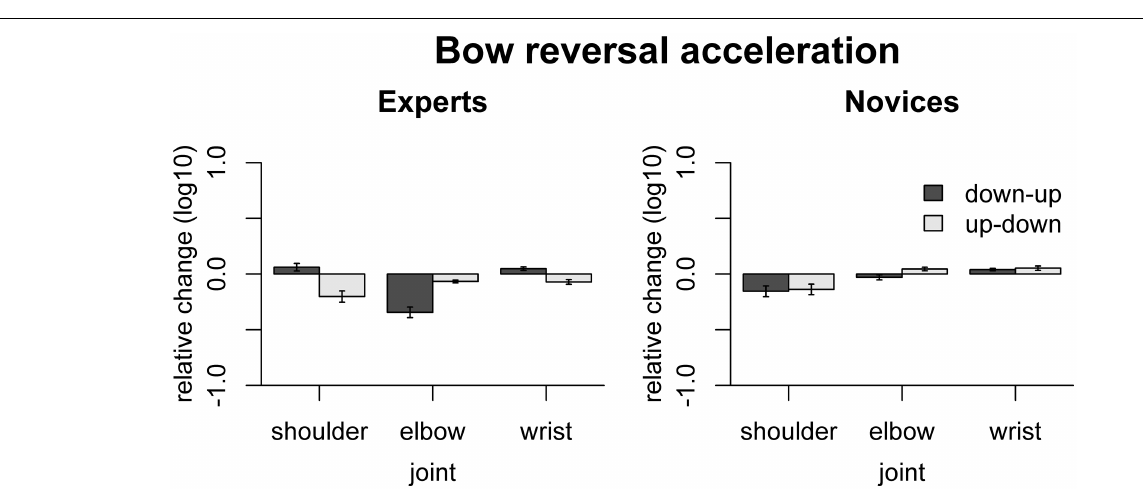
FIGURE 7 | Results of the freezing analysis for bow acceleration amplitude. Error bars indicate SE across